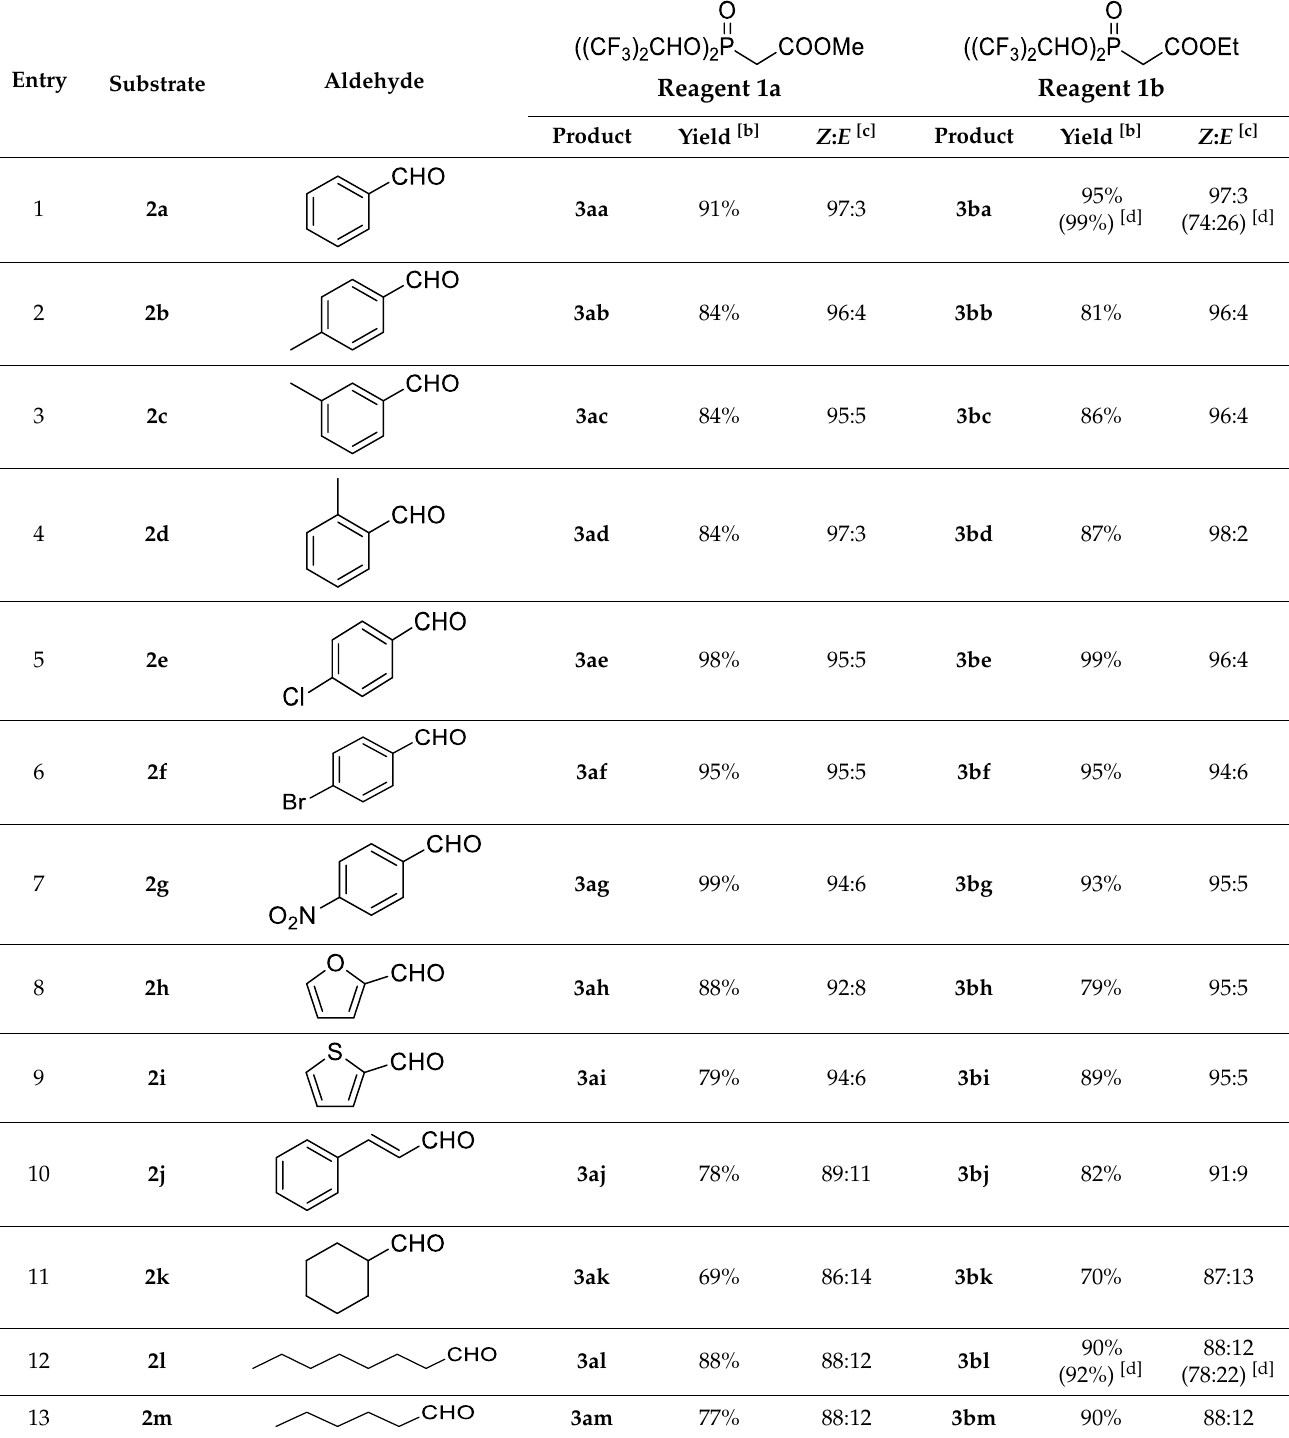
Table 3. Reactions of 1a and 1b with aldehydes 2a–2m [a] .